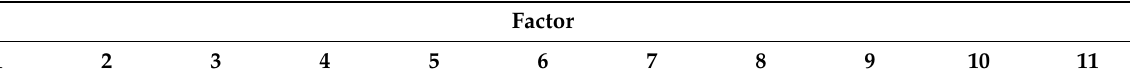
Figure A2. Scree plot (FA). Table A3. Factors.